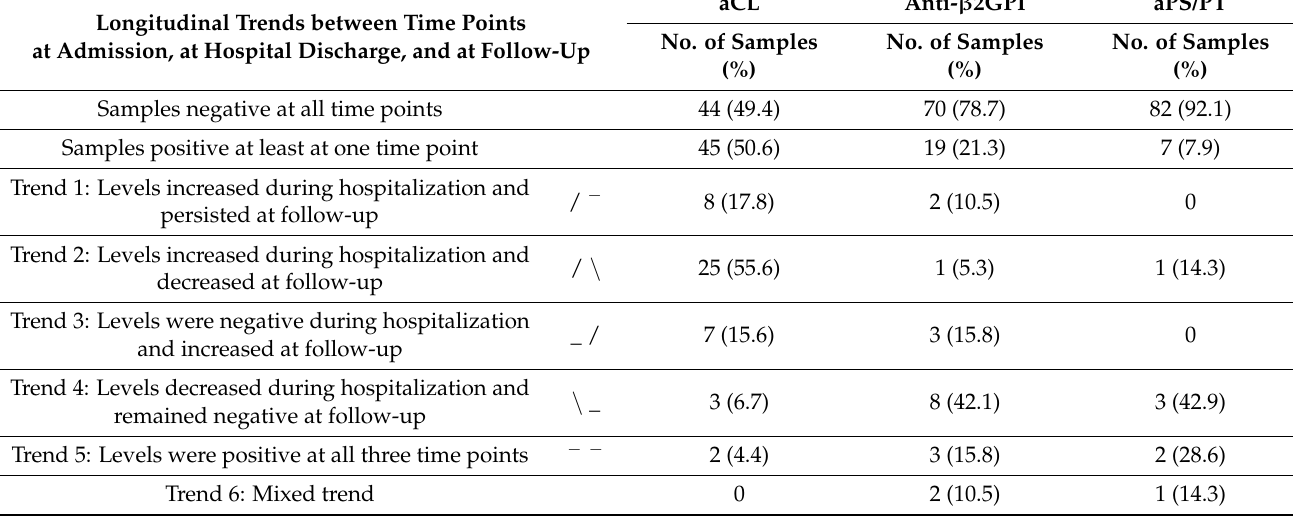
Table 3. aPL dynamics in COVID-19 patients during infection with SARS-CoV-2, presented as a longitudinal